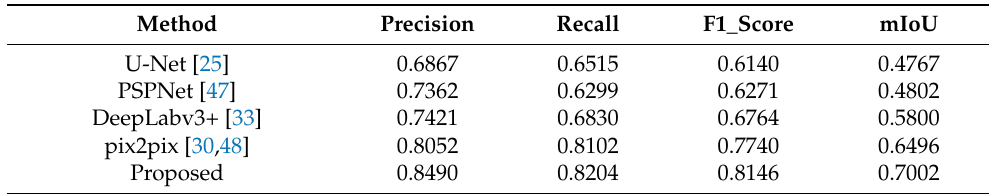
Table 4. Precision , Recall , F 1 _score , and mIoU values of U-Net, PSPNet, DeepLabv3+, pix2pix, and the proposed method performed using the test